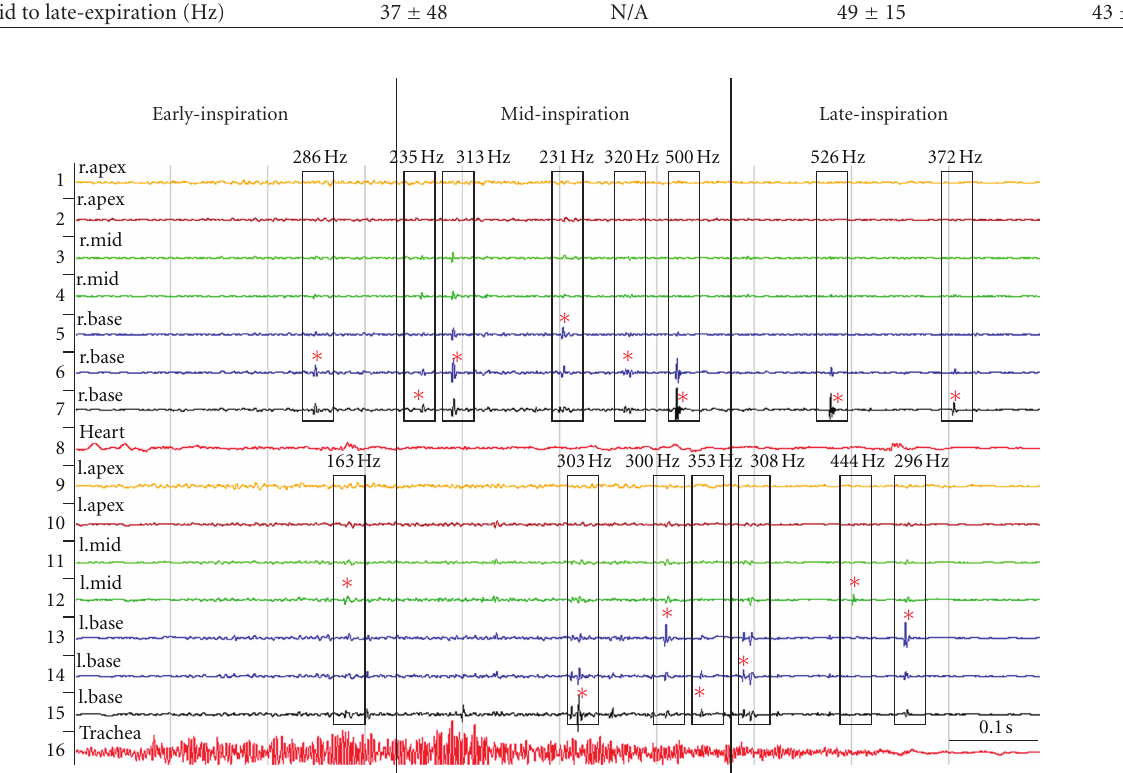
From early to mid-inspiration (Hz) From mid to late-inspiration (Hz) Table 4: An average change in crackle pitch among the patients whose crackle pitch decreased during expiration. Pneumonia CHF From early to mid-expiration (Hz) From mid to late-expiration (Hz)